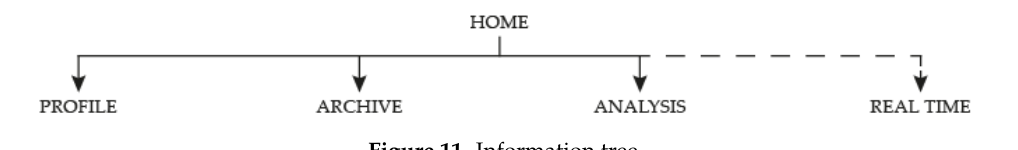
Figure 11. Information tree.